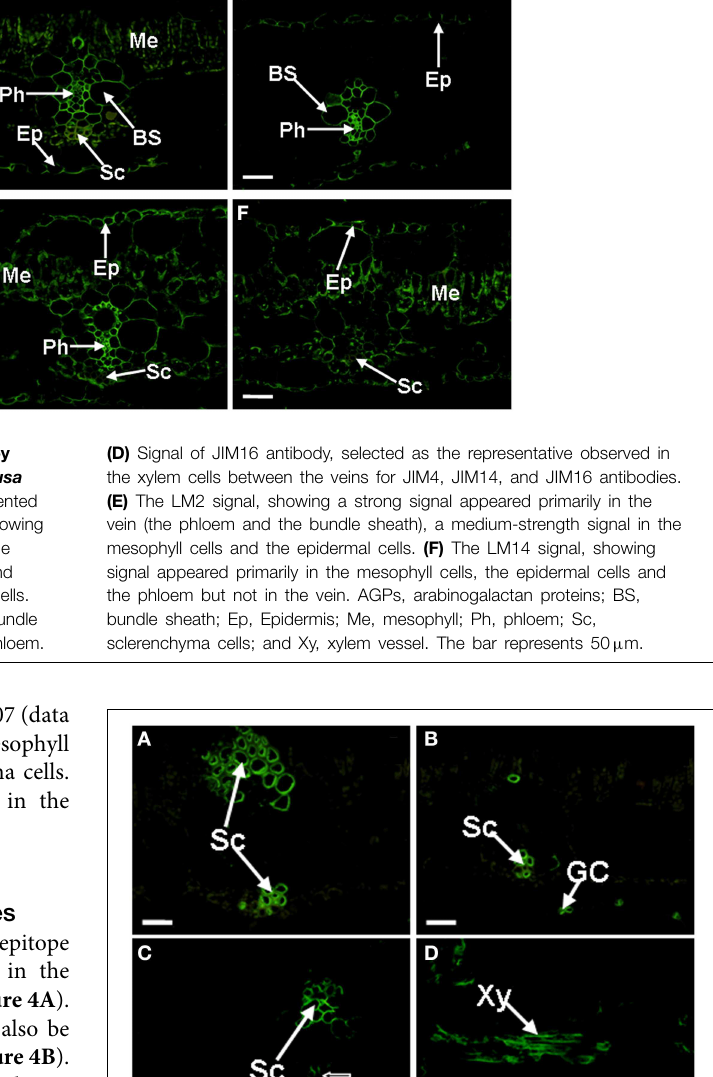
FIGURE 4 | Localization of JIM8 epitopes in banana ( Musa spp.) leaves. Cross-sections through the lateral vein are presented for all cases. (A) The epitopes appeared in the sclerenchyma cells of Musa spp. ABB Dajiao (chilling-tolerant genotype). (B) The epitopes appeared also in the GCs in both genotypes. (C) The epitopes appeared in Musa spp. AAA cv Baxijiao (chilling-sensitive genotype), exhibiting some cells of the vascular bundle (an arrow) were also labeled besides the sclerenchyma. (D) The epitopes observed in some xylem vessel in both genotypes. GC, guard cells; Sc, sclerenchyma cells; and Xy, xylem vessel. The bar represents 50 µ m. signal in guard cells was much less frequently observed (data not